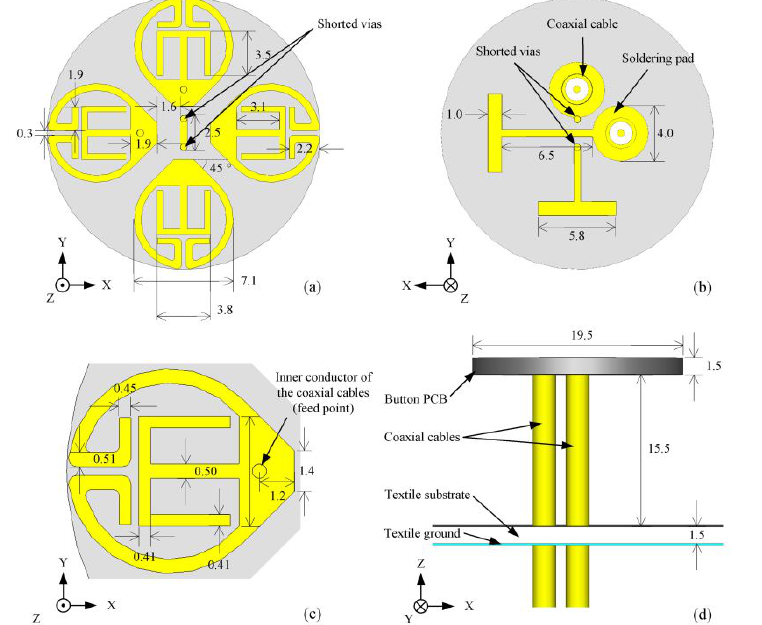
Figure 13. Illustration of the wearable button antenna. Reprinted/adapted with permission from Ref. [50]: Copyright 2022, IEEE. ( a ) top view; ( b ) bottom view; ( c ) radiator structure; and ( d ) side